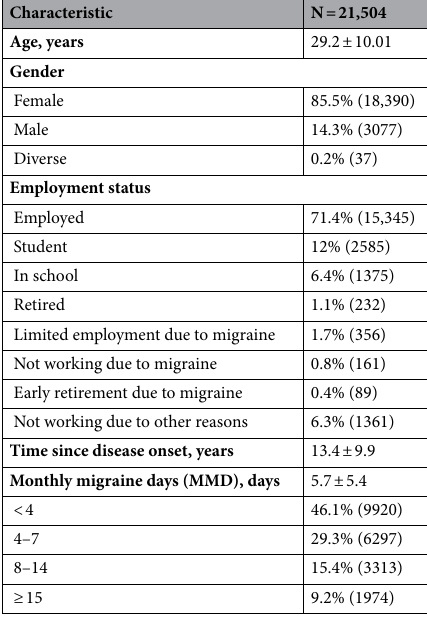
Table 1. Demographic description of survey participants. Data are shown as mean ± SD or %